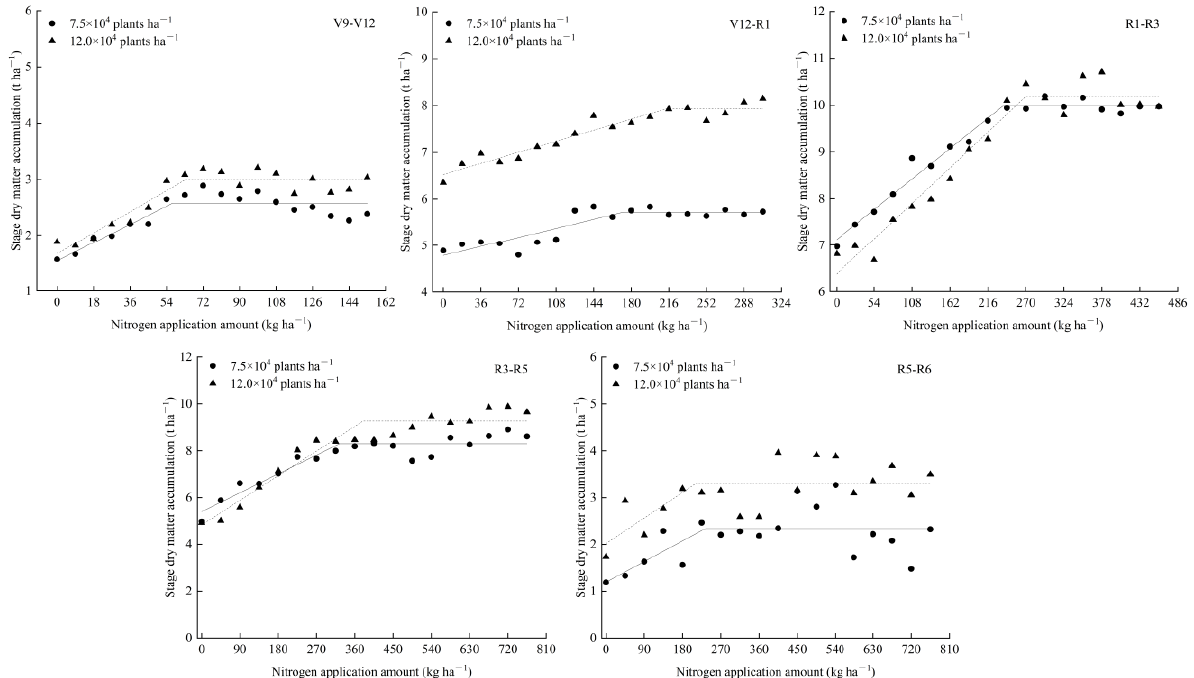
Figure 6. Effect of nitrogen application rate on dry matter accumulation at each growth stage under different density conditions. Table 4. Optimal nitrogen application based on the dry matter accumulation during the maize growth stage.